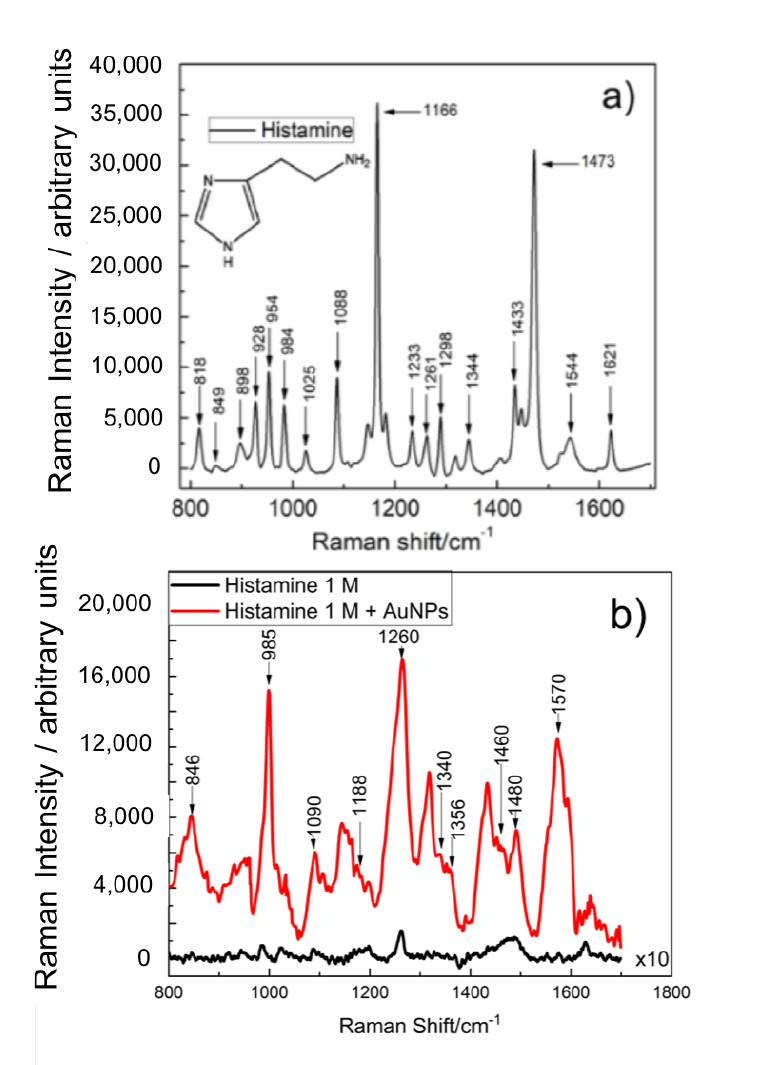
Figure 3. ( a ) Raman spectrum of powder histamine after baseline correction using Vancouver algorithm, where the modes observed correspond with the work reported by Collado et al. [42]. ( b ) Raman spectra of histamine 1 M with (red) and without AuNPs